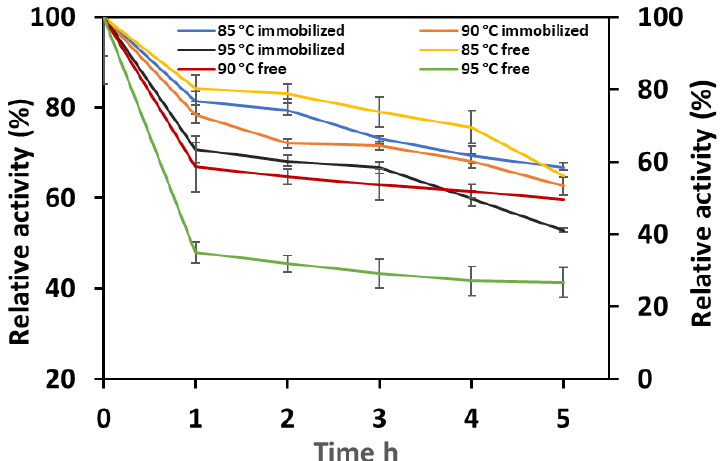
Figure 5. Thermostability of free and immobilized Man/Cel5B. The enzymes were incubated at 80, 85 and 90 °C for 5 h in the absence of substrate, and the residual activity was examined at optimal conditions. Table 2. Thermodynamic parameters for irreversible inactivation of free and immobilized Man/Cel5B. Parameter Immobilized Enzyme Free